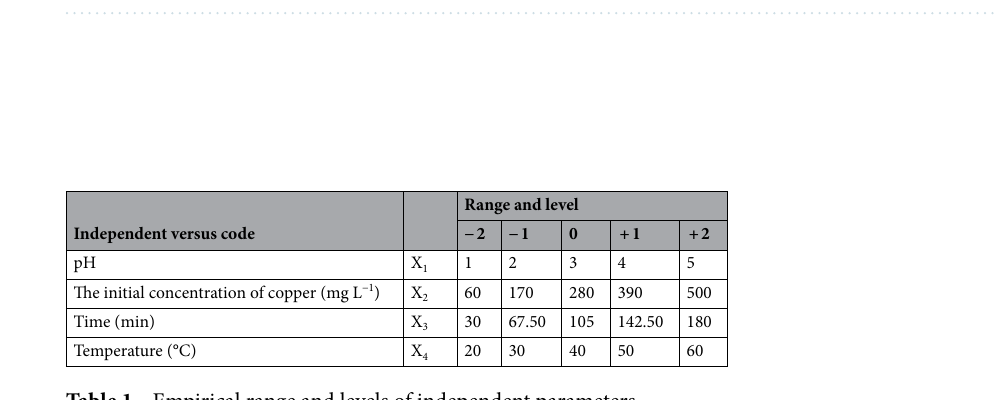
Figure 1. Multistep process of GFLE nanocomposite preparation and Cu(II) ions absorption process.